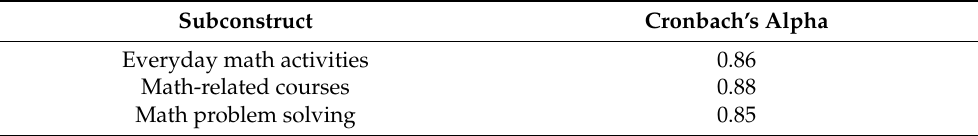
Table 3. Cronbach’s alpha results of the first and second sample.